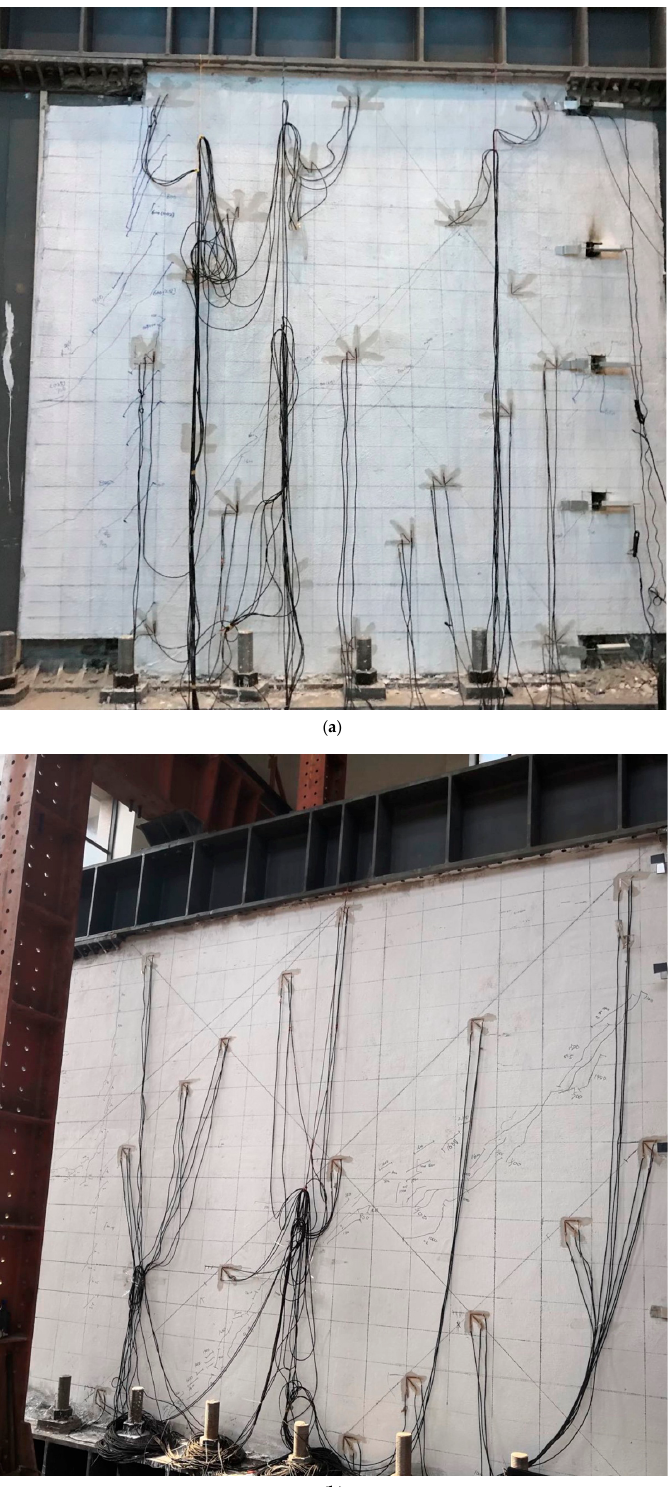
Figure 5. Crack distribution diagram obtained when the drift angle reached 1/400: ( a ) specimen W1 and ( b ) specimen W2.